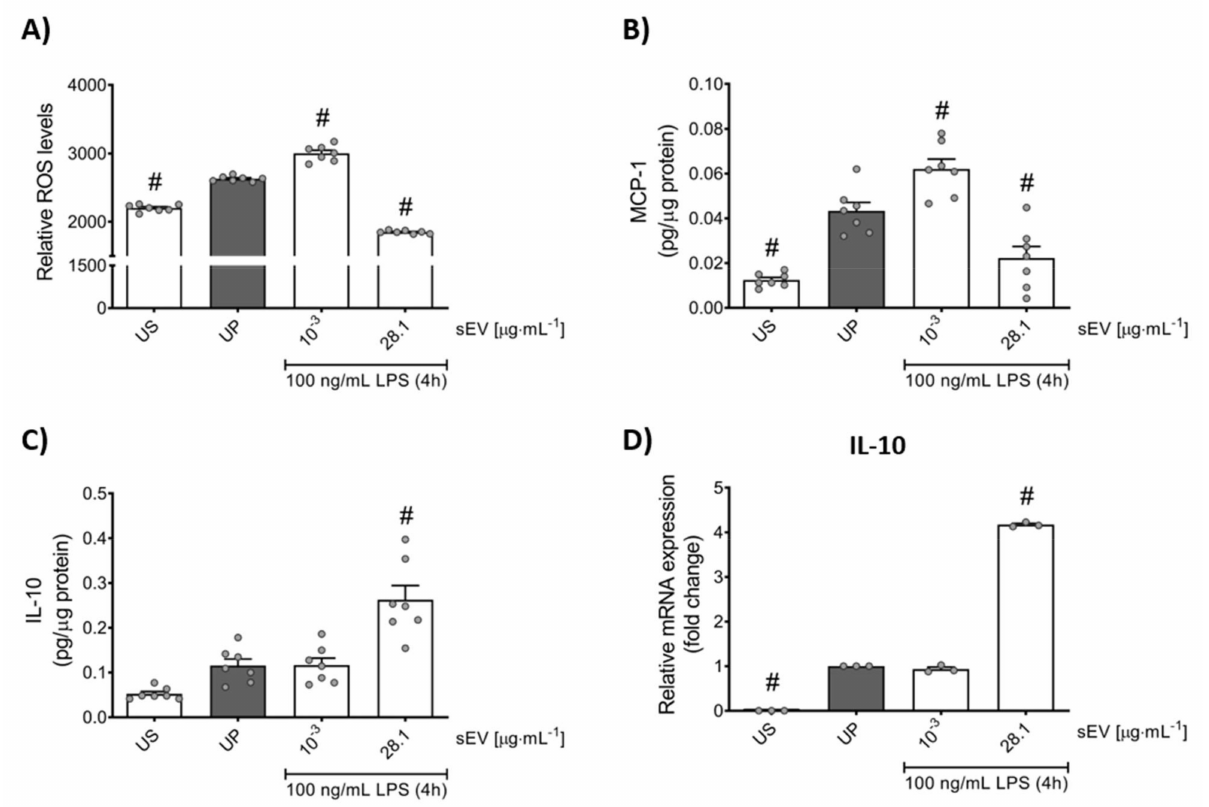
Figure 3. Role of microbiota-derived small EVs altering pro- and anti-inflammatory mediators in bone marrow neutrophils. Murine bone marrow neutrophils were primed for 45 min by microbiota- derived small EVs (low concentration: 1 ng/mL; high concentration: 28.1 µ g/mL) and re-challenged with 100 ng/mL LPS for 4 h on day 2. Production of ( A ) ROS ( n = 7) was determined by DCFDA assay, whereas ( B ) MCP-1 ( n = 7) and ( C ) IL-10 ( n = 7) were measured by ELISA (normalized to total protein concentration). Real-time qPCR was used to analyze the gene expression of ( D ) IL-10 ( n = 3; unprimed state assigned as 1.0). Data are presented as scatter dot plots, mean + SEM, # p < 0.05, # versus unprimed condition (UP, gray